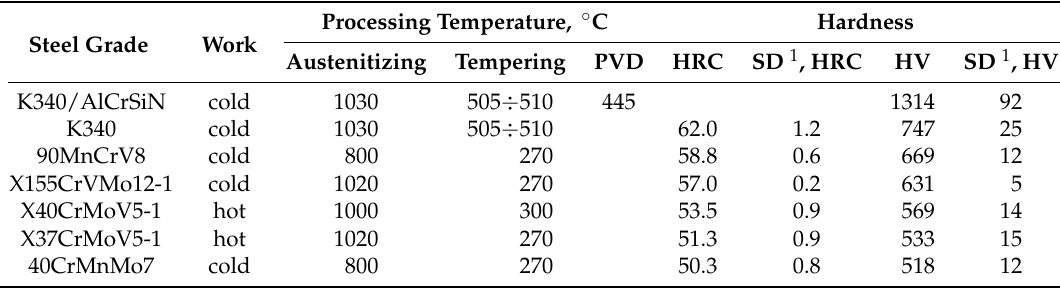
Table 4. Treatment parameters and overall surface hardness of the tested